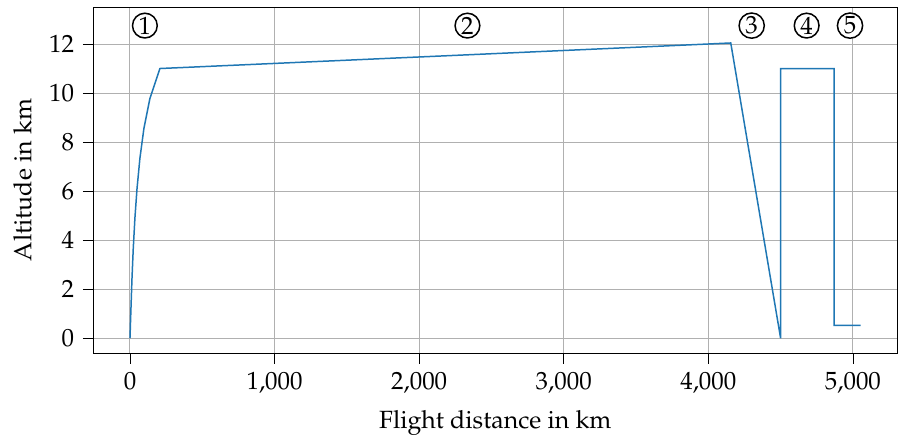
Figure 6. Mission profile for the design mission, including: departure (1), cruise (2), approach (3), diversion (4), loiter (5).